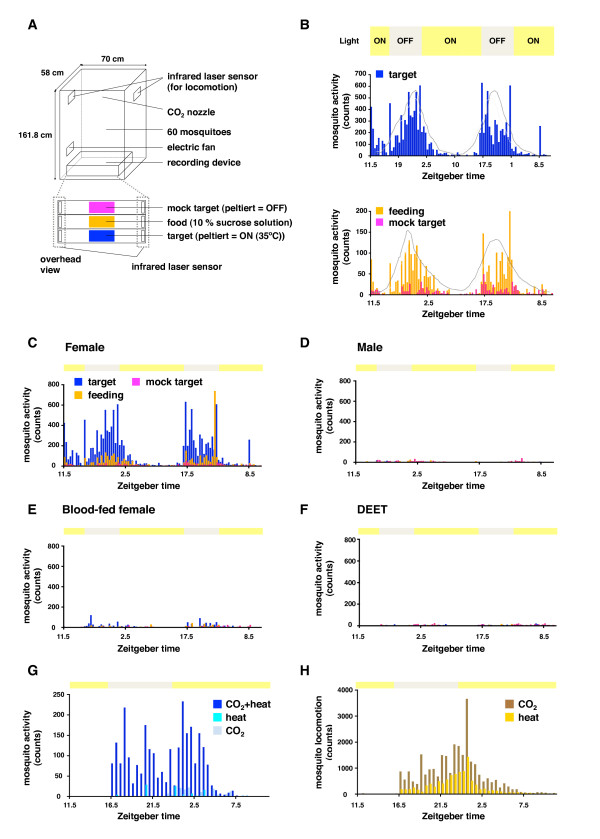
Mosquito host-seeking behavior is reproduced in the artificial environment. (A) Schematic view of a mosquito cage containing a recording device. (B) A typical pattern of selected host-seeking behavior of 60 female mosquitoes monitored for 48 h by the automated-device shown in (A). CO2 is delivered intermittently (2 sec every 15 min) during the 48 hours assay. Upper crossbar indicates light (yellow)-dark (gray) timer controlled conditions (6:00 ON; 22:00 OFF). (C-F) Patterns of selected host-seeking behavior (48 h) of females (C), males (D), blood-fed females (E), and females served with target Peltier covered with DEET (F). Note that only non blood-fed female mosquitoes show the selected host-seeking behavior. Mosquito behavior is represented as: host-seeking (blue), sugar-feeding (orange), and background behavior (magenta). (G) Both CO2 and heat are essential for activation of the selected host-seeking behavior (24 h). The behavioral assay was performed for 24 hours under each condition with CO2 only (light blue), heat only (light green), and CO2 + heat (blue), respectively. (H) CO2-activated simple locomotion activity of female mosquitoes (24 h). Note that female mosquitoes show higher locomotion activity induced by CO2 (dark orange) than by heat (light orange).